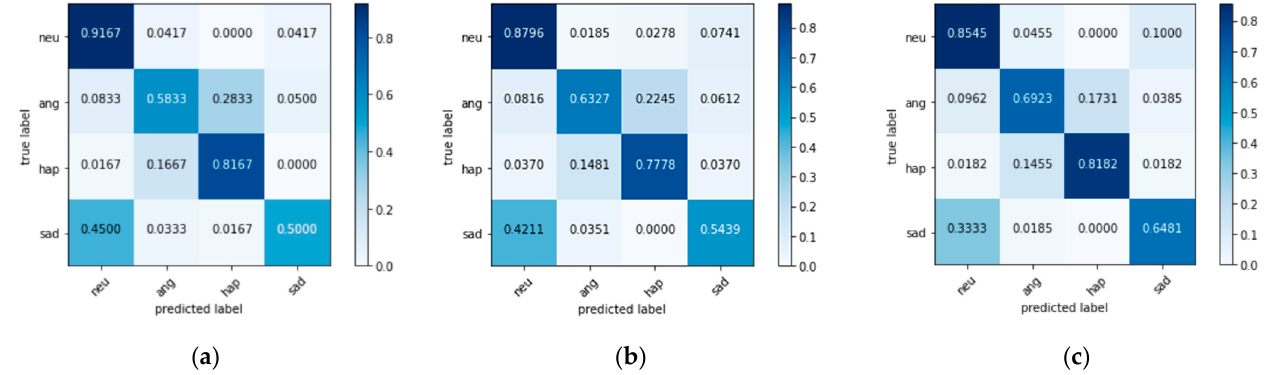
Figure 6. The confusion matrix of the SAVEE corpus. ( a ) The confusion matrix for the MSFL_ST model. ( b ) The confusion matrix for the MTL_DNN model. ( c ) The confusion matrix for the MSFL model.